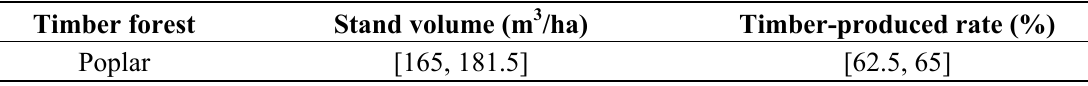
Table 4. Technical parameters of the timber forest during a felling period.